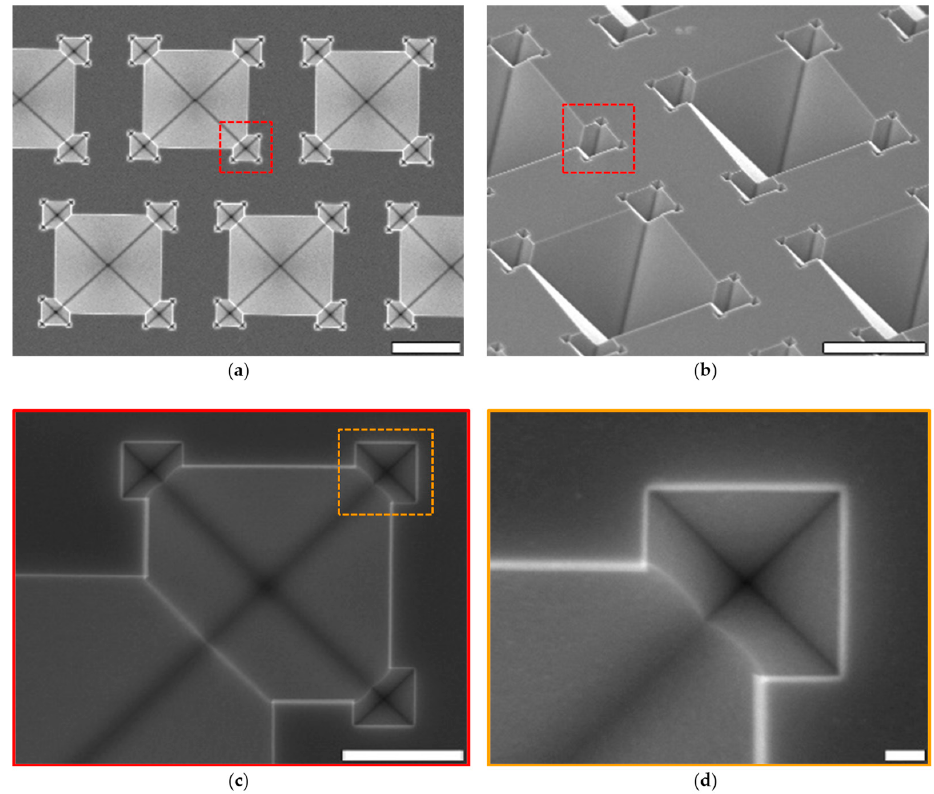
Figure 14. Top-view SEM images ( a – d ) of the formation of third generation (G3) fractals after anisotropic etching in TMAH. In ( b ), substrate was 45° tilted. The enlarged areas are indicated by the red and orange dashed lines. Scalebars: ( a , b ) 5 µm, ( c ) 1 µm and ( d ) 100 nm.